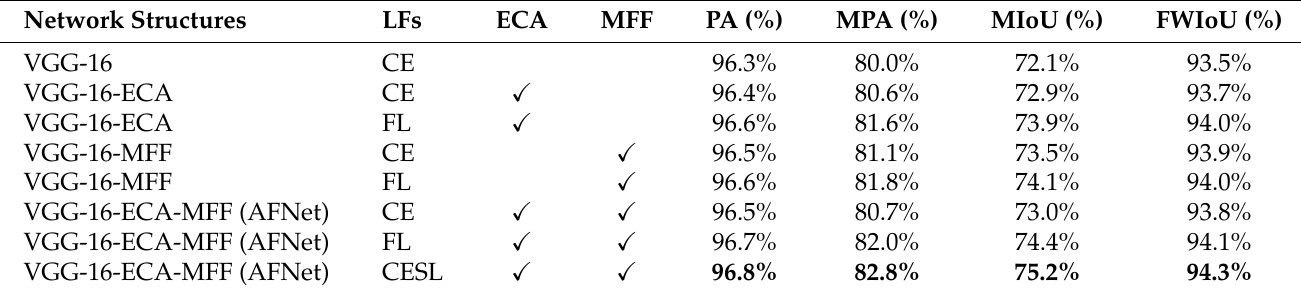
Table 1. Ablation experiment of the proposed modules on the DEM